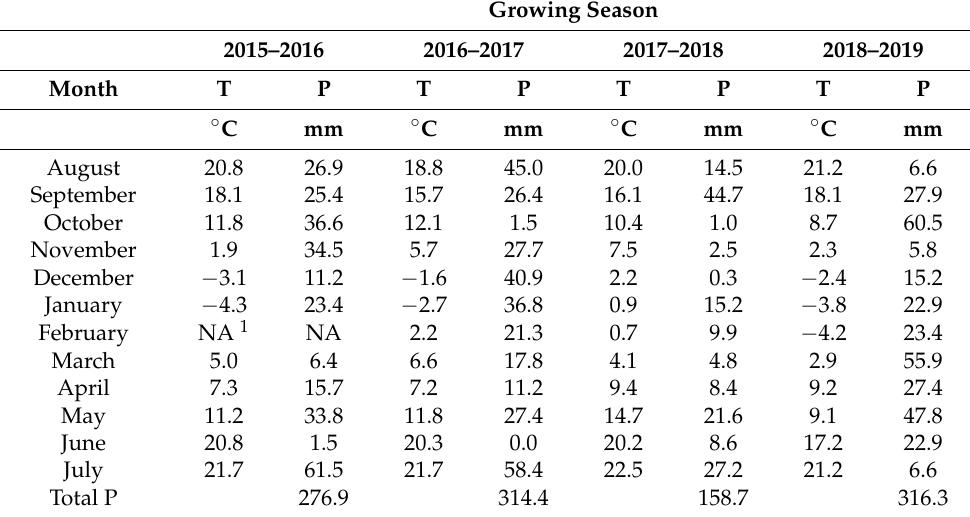
Table 3. Monthly average temperature (T) and precipitation (P) at the Southwestern Colorado Research Center in Yellow Jacket, CO during the experimental period. Total P throughout growing season (defined as August–July) is displayed in italics.